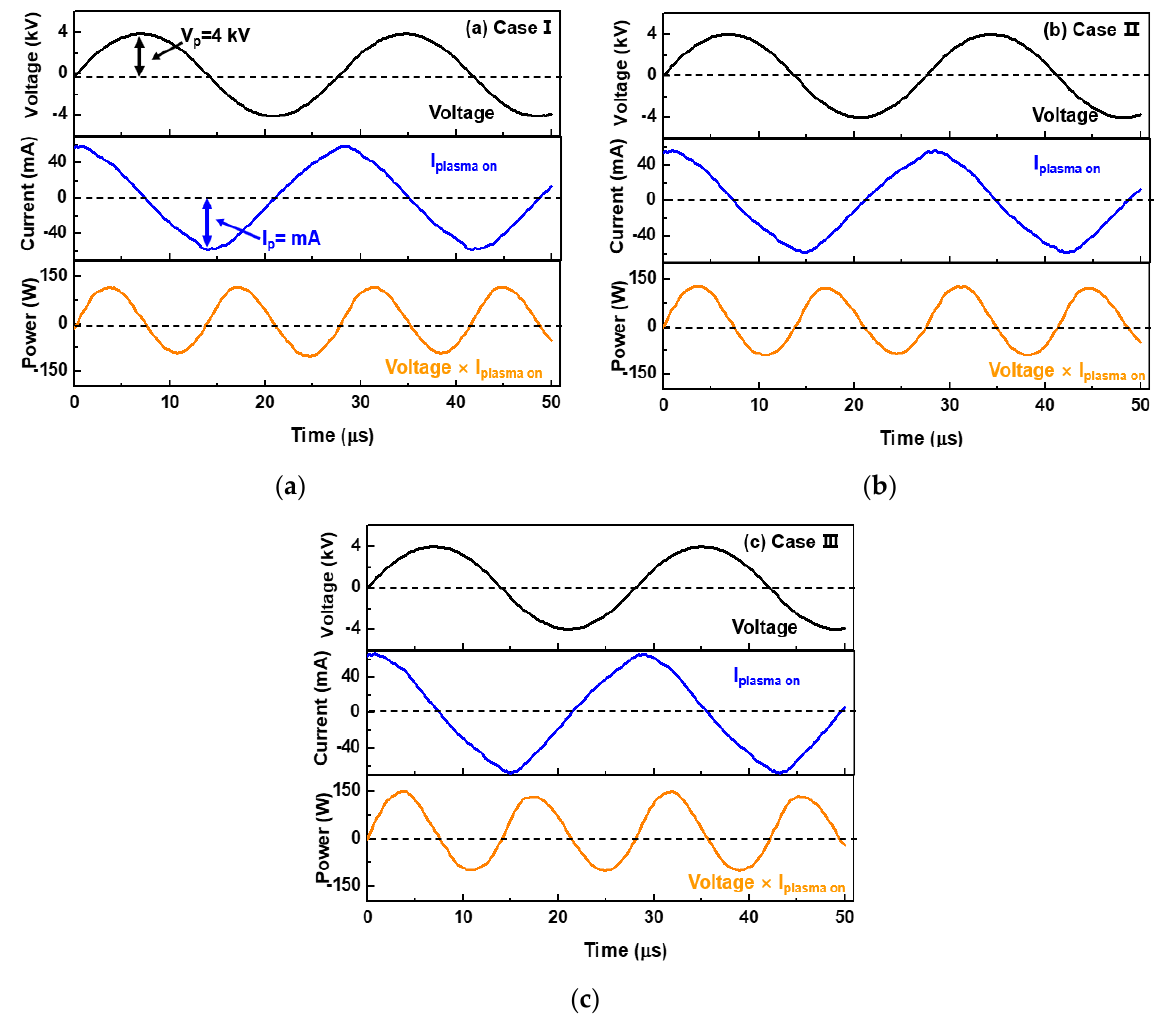
Figure 3. Characteristics of applied voltage, total current in plasma ON state, and instantaneous power of the APPR under optimal conditions (argon flow rate = 1300 sccm and bluff − body height = 15 mm) with respect to three electrode configurations of cases ( a ) I, ( b ) II, and ( c ) III. For all cases, the average power, P a in the APPR was calculated from Equation (1).